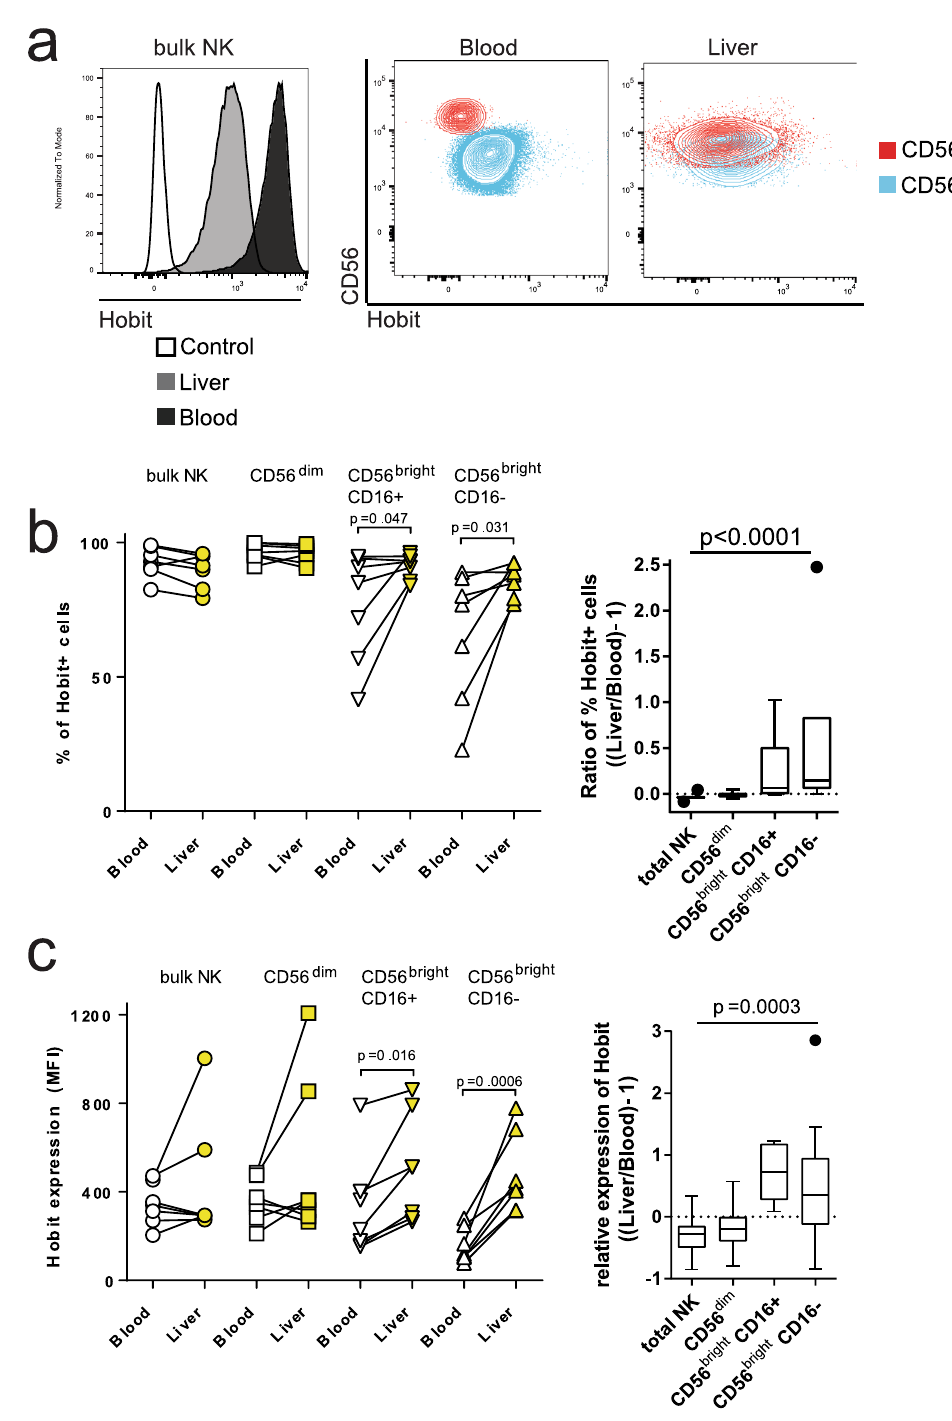
Figure 2. Increased frequencies and expression of Hobit on CD56 bright liver NK cells. ( a ) Histogram (left panel) showing Hobit expression on bulk NK cells in the blood (dark grey), the liver (light grey) and a FMO control (white). Contour plots showing the expression of Hobit on CD56 dim (blue) and CD56 bright (red) NK cells in the blood and liver. ( b ) Frequency (left panel) of Hobit pos bulk, CD56 dim ,CD56 bright CD16 + and CD56 bright CD16- NK cells in the blood (open symbols) and liver (yellow symbols). Ratio of the frequency (right panel) of Hobit pos cells in each subset between liver and peripheral blood. ( c ) Expression (left panel) of Hobit on bulk, CD56 dim , CD56 bright CD16 + and CD56 bright CD16- NK cells in the blood (open symbols) and liver (yellow symbols). Ratio of the expression (right panel) of Hobit in each subset between liver and peripheral blood samples. Individual data points are blotted in the graphs on the left side. Box and whiskers (Tukey) was used to depict the expression ratio between liver and blood. Wilcoxon matched pair sign rank test was used to determine statistical differences in the scatter plots and Friedman test was used for box